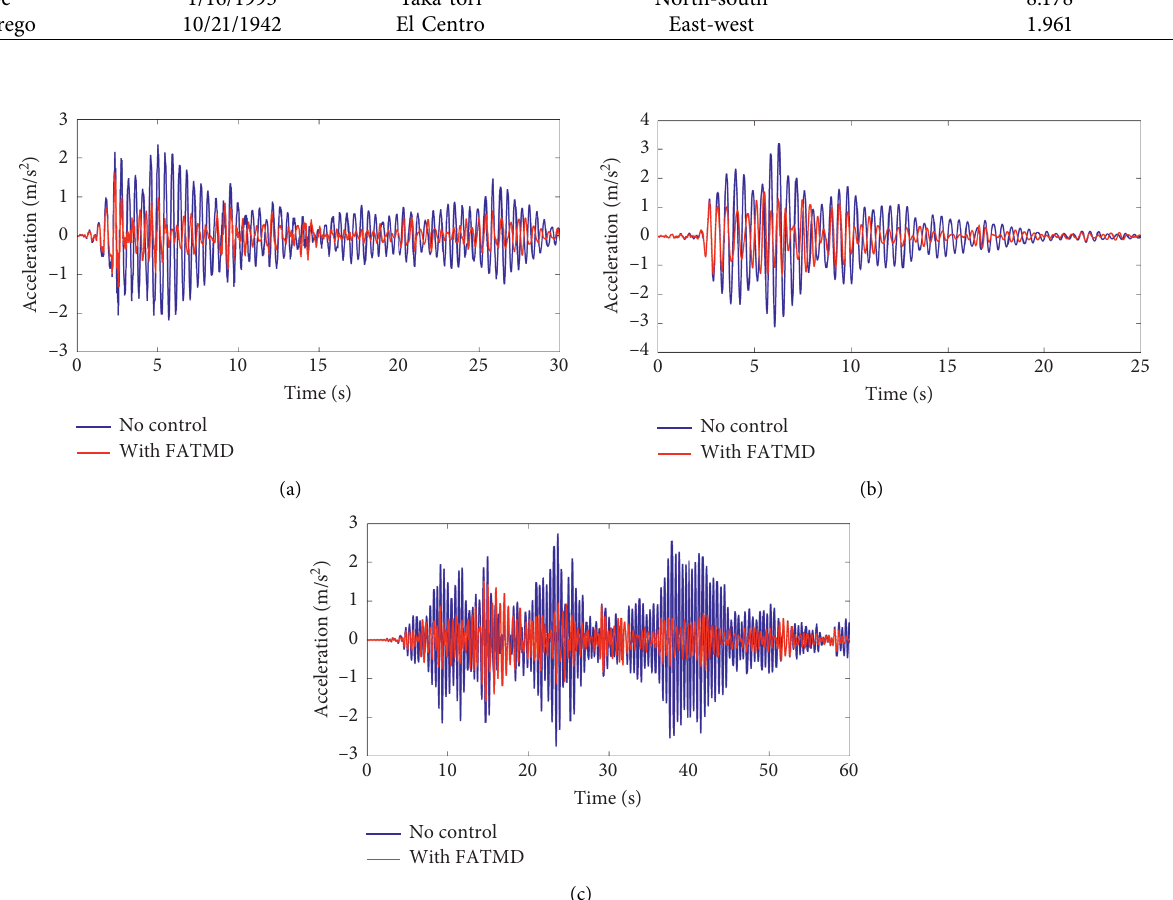
Figure 17: The acceleration time history in the midspan of the bridge. (a) Imperial Valley earthquake, (b) Kobe earthquake, and (c) Borrego